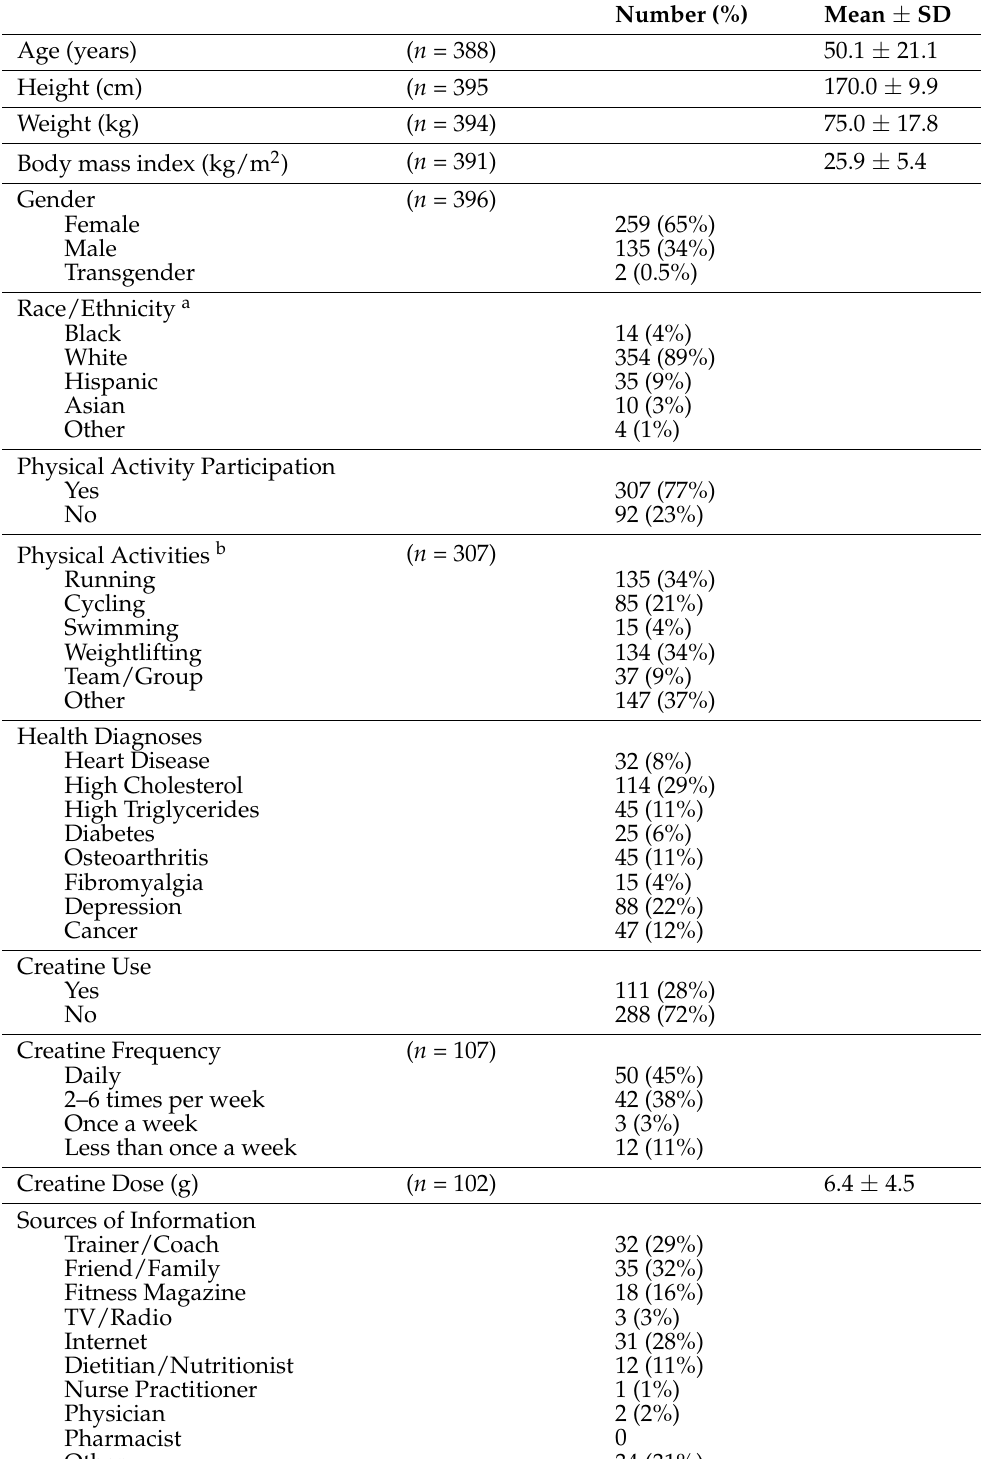
Table 1. Characteristics of all ( N = 399)